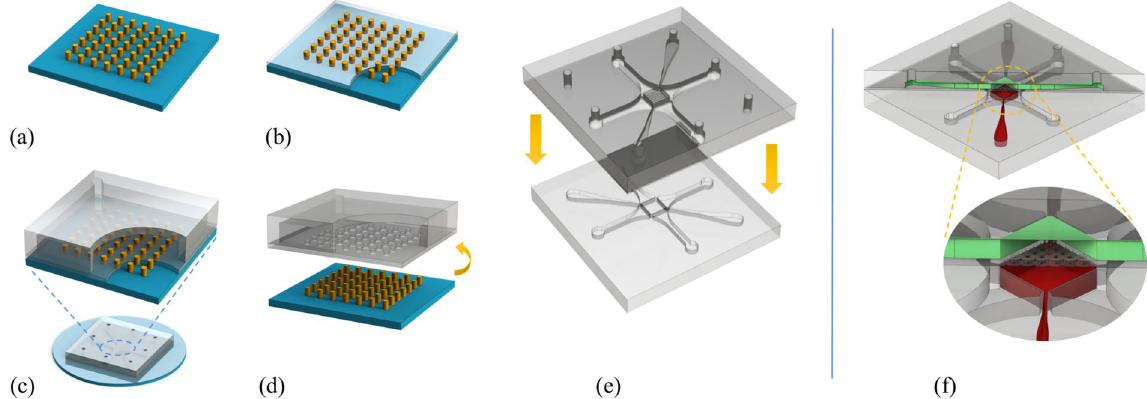
Figure 7. MCD microfabrication. Schematic representation of the membrane fabrication steps ( a,b ) and of the multi-step bonding process: upper half with the PM ( c,d ) and final alignment of the two halves ( e ). 3D schematic view of the assembled MCD ( f ): upper (green) and lower (red) culture chambers with the interposed PM (gray).